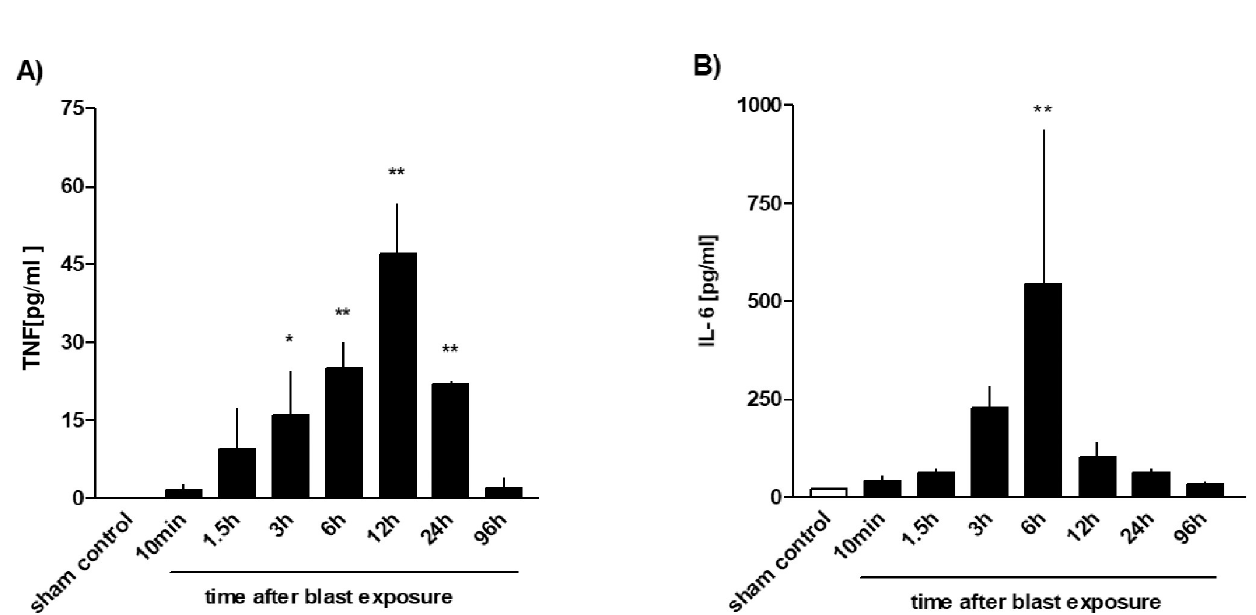
Fig 8. Time course of TNF and IL-6 release after thoracic trauma. The animals were sacrificed 10 min (n = 6), 1.5 h (n = 3), 3 h (n = 3), 6 h (n = 3), 12 h (n = 4), 24 h (n = 3) or 96 hours (n = 3) after blast exposure, non-traumatized animals served as sham controls (n = 9). A) TNF and B) IL-6 release were determined in BALFs. Data were statistically analysed by one-way ANOVA and Dunnett’s multiple comparison test: � p < 0.05 and �� p < 0.01 vs. sham control. Data represent means ± SEM, number of experiments (n) in parentheses.